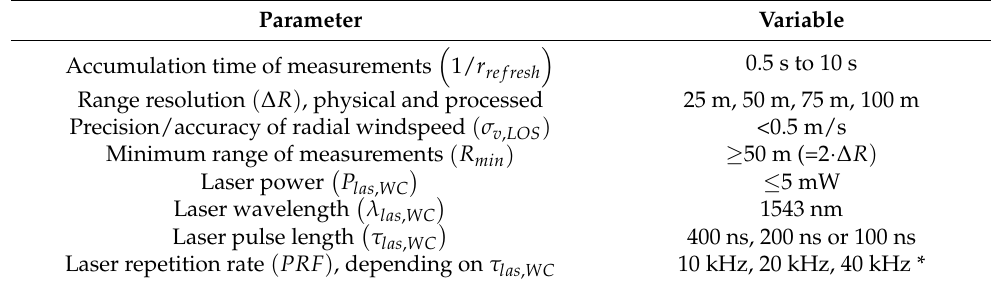
Table 3. Relevant performance characteristics of the used coherent DWL Vaisala/Leosphere Windcube ® 200S (according to